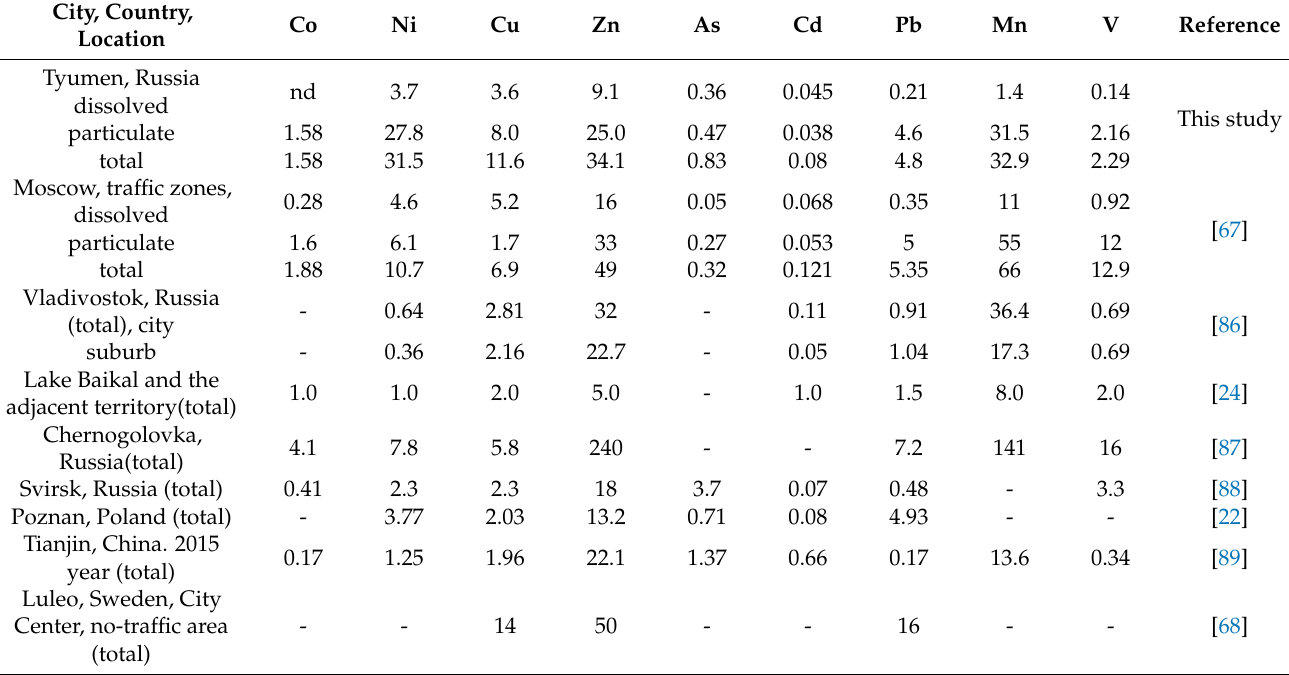
Table 3. A comparison of trace element concentrations in snow from different locations ( µ g · L − 1